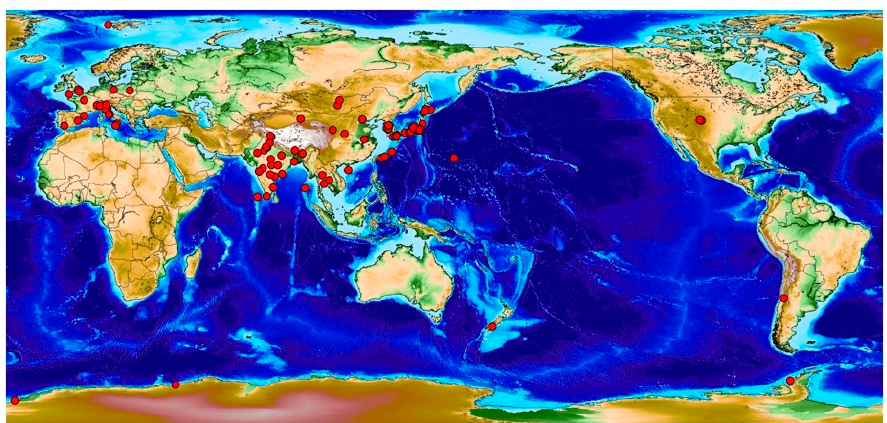
Figure 2. Map of the global SKYNET sites.